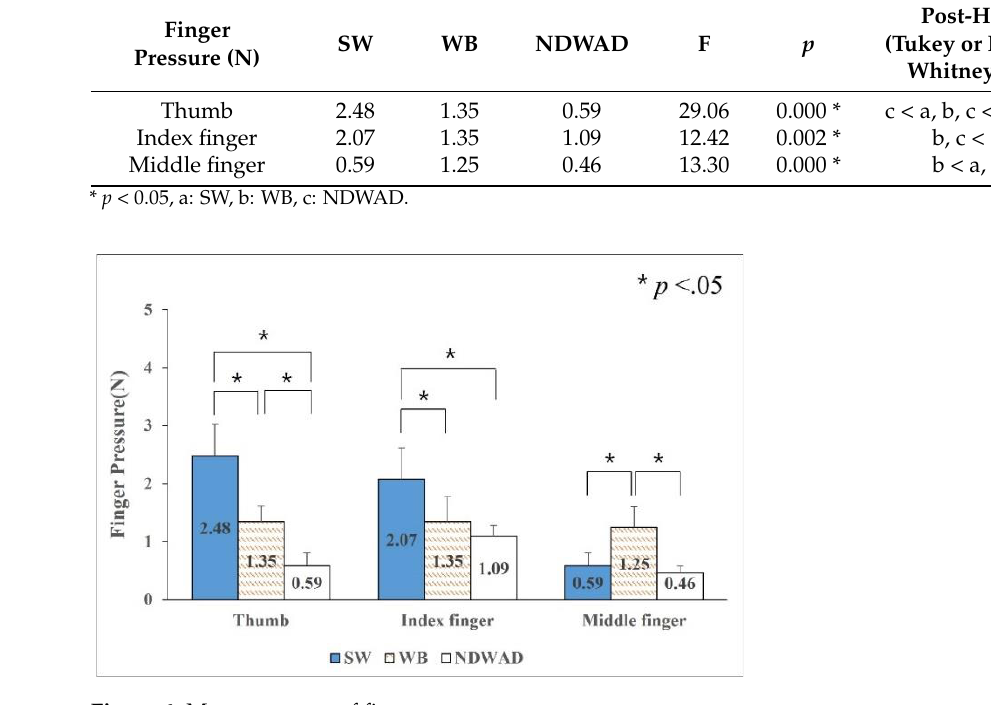
Figure 6. Mean pressure of finger.